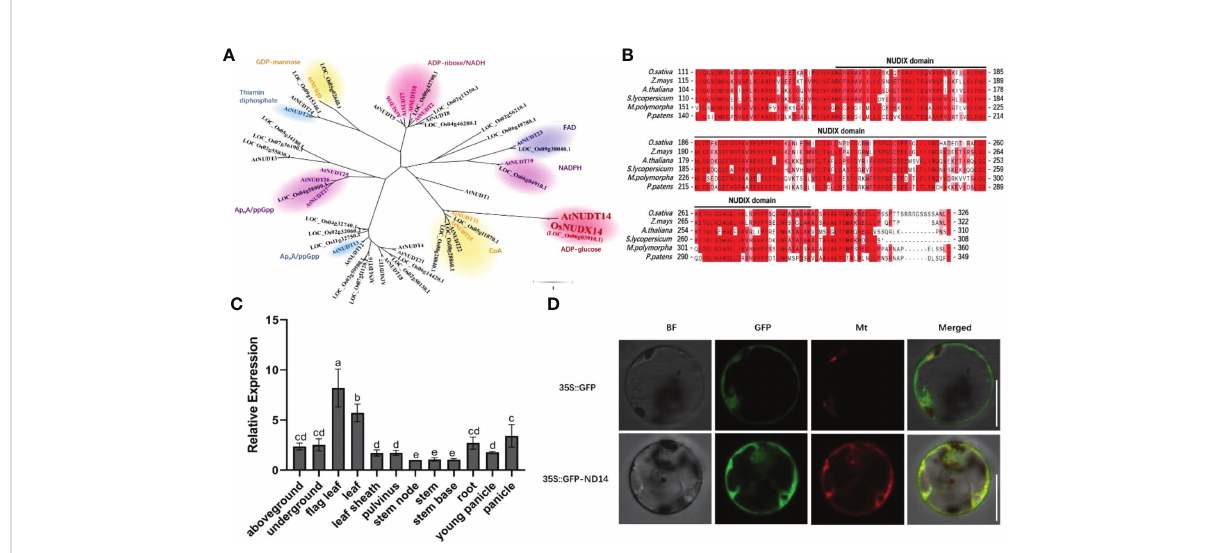
FIGURE 1 OsNUDX14 characteristics and expression pro fi le. (A) Phylogenetic tree constructed by Molecular Evolutionary Genetics Analysis 5(MEGA5) software using the neighbor-joining method. (B) Alignment of partial amino acid sequences among the orthologs of OsNUDIX14. The part below the black line is predicted to be a Nudix hydrolases domain using the Pfam database. (C) OsNUDX14 expression in various organs was detected using quantitative reverse transcription-polymerase chain reaction (RT-qPCR). Above- and under-ground tissues represent shoots, leaves, and roots of two-week-old rice seedlings. Expression values were relative to the expression value of stem node. Data were analyzed using a two-way analysis of variance with post hoc Tukey tests (letters indicate signi fi cant differences between samples at p < 0.05). (D) OsNUDX14 subcellular localization in rice protoplast. GFP-OsNUDX14 (green channel) fl uorescence was detected with mt-rkCD3-991 in red channel (Nelson et al., 2007). Bar = 10 µm.